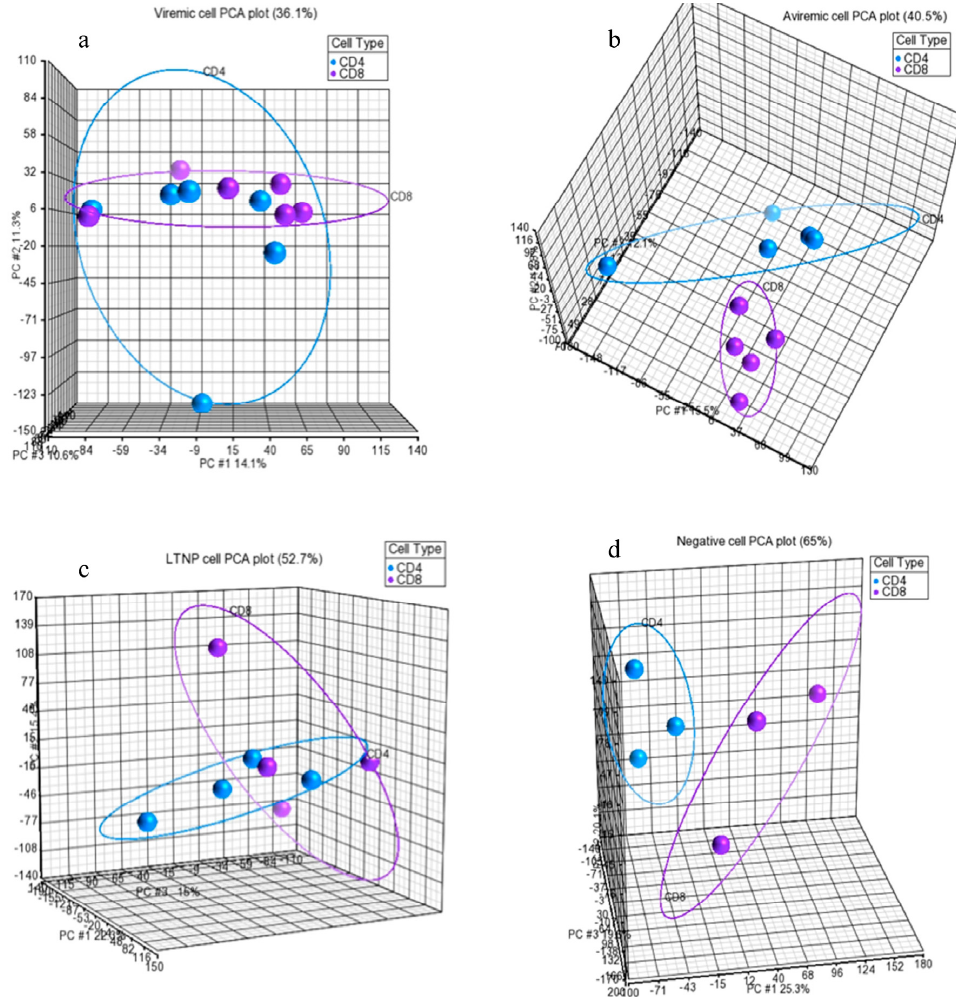
Figure 2. PCA for each disease state, comparing CD4+ and CD8+ T-cells. Analysis of CD4+ and CD8+ cells from patient groups viremic ( a ); aviremic ( b ); LTNP ( c ) and negative ( d ). Azure = CD4+ T-cells, Purple = CD8+ T-cells. ( a ) Viremic CD4+ ( n = 6) vs. CD8+ ( n = 6). X Axis (Component 1) = 14.1%, Y Axis (Component 2) = 11.3%, Z Axis (Component 3) = 10.6%. ( b ) Aviremic CD4+ ( n = 5) vs. CD8+ ( n = 5). X axis (Component 1) = 15.5%, Y axis (Component 2) = 12.8%, Z axis (Component 3) = 12.1%. ( c ) LTNP CD4+ ( n = 4) vs. CD8+ ( n = 4). X axis (Component 1) = 22.3%, Y axis (Component 2) = 15.4%, Z axis (Component 3) = 15%. ( d ) Negative CD4+ ( n = 3) vs. CD8+ ( n = 3). X axis (Component 1) = 25.3%, Y axis (Component 2) = 20.1%, Z axis (Component 3) = 19.6%.